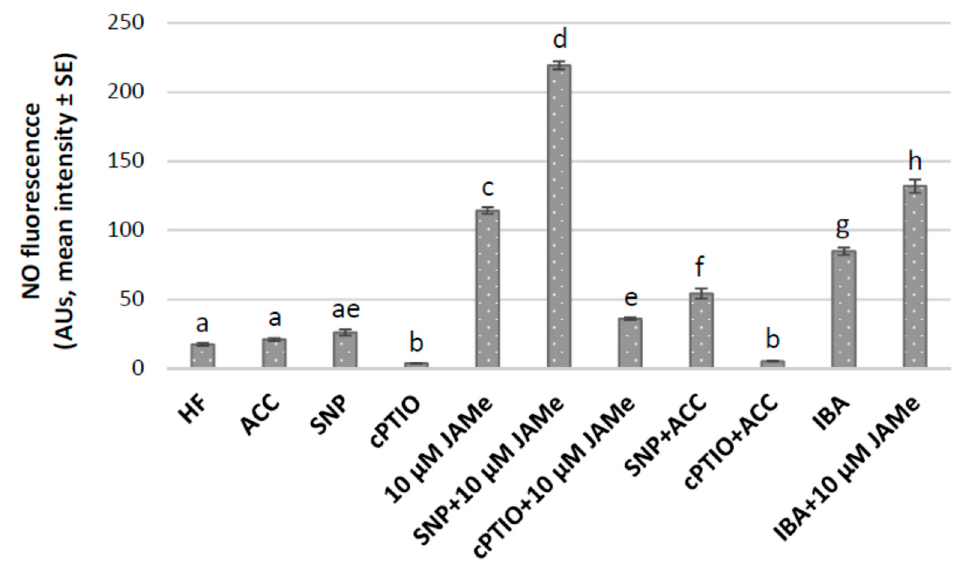
Figure 8. Quantification of the epifluorescence signal due to nitric oxide (NO) production, by means of DAF-FMDA probe, in the basal hypocotyl pericycle cells and in their early derivatives of Col-0 (wt) seedlings grown in darkness for 22 DAS with different treatments. Mean intensity (± standard error (SE)) in Arbitrary Units (AUs) in seedlings cultured in control condition (HF) or with 0.1 μ M ACC (ACC), 50 μ M SNP (SNP), 100 μ M cPTIO (cPTIO), 10 μ M JAMe, SNP + 10 μ M JAMe, cPTIO + 10 μ M JAMe, SNP + ACC, cPTIO + ACC, 10 μ M IBA (IBA), 10 μ M IBA + 10 μ M JAMe. Different letters among treatments indicate significant differences at least at p < 0.05. The same letter indicates no significant difference. One-way ANOVA followed by Tukey’s post-test. n = 100.